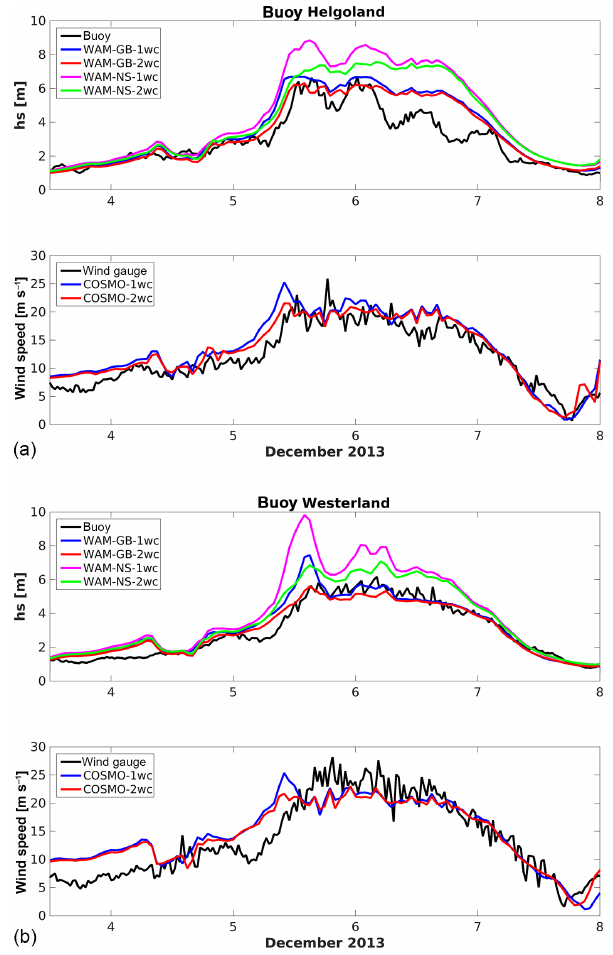
Figure 8. (a, b) Significant wave height (m, top panels) and wind speed (ms − 1 , bottom panels) during storm Xaver at the Hel- goland (a) and Westerland/Sylt (b) buoys.